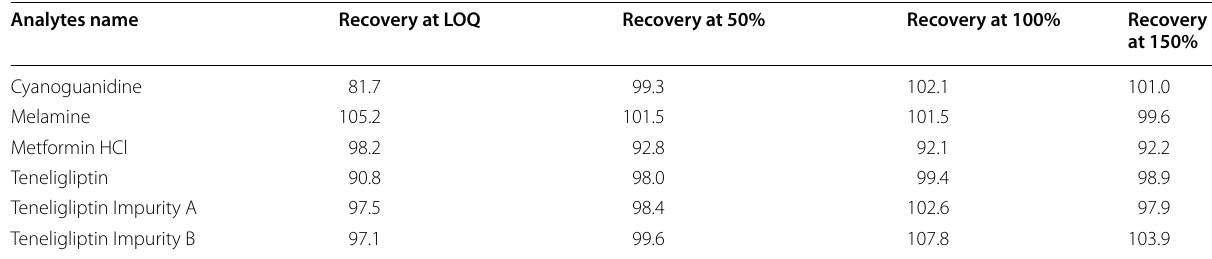
Table 3 Recovery study results in %